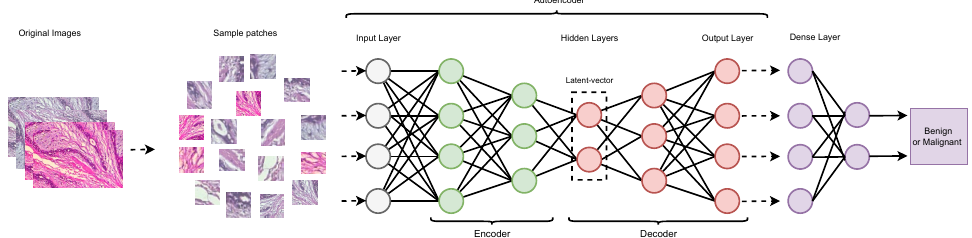
Figure 4. An illustration of the autoencoder model for breast-cancer diagnosis.